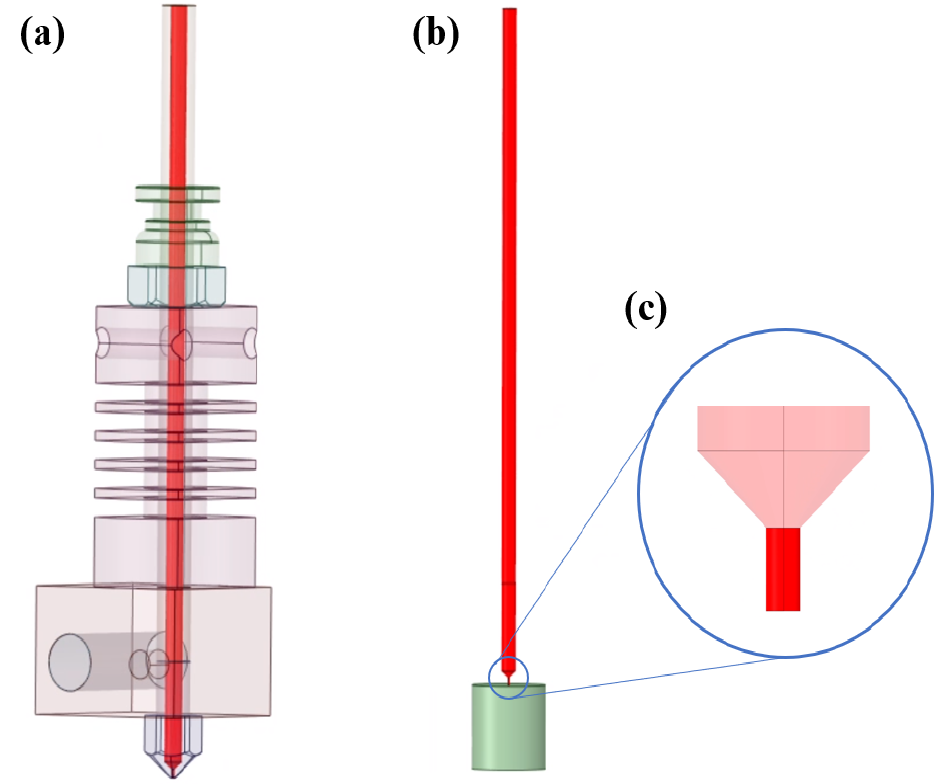
Figure 5. Shared filament temperature boundary among the FMUs of the digital twin: ( a ) Boundary in the forced convection simulation; ( b ) Boundary in the melting simulation; ( c ) Boundary in the microchannel simulation.